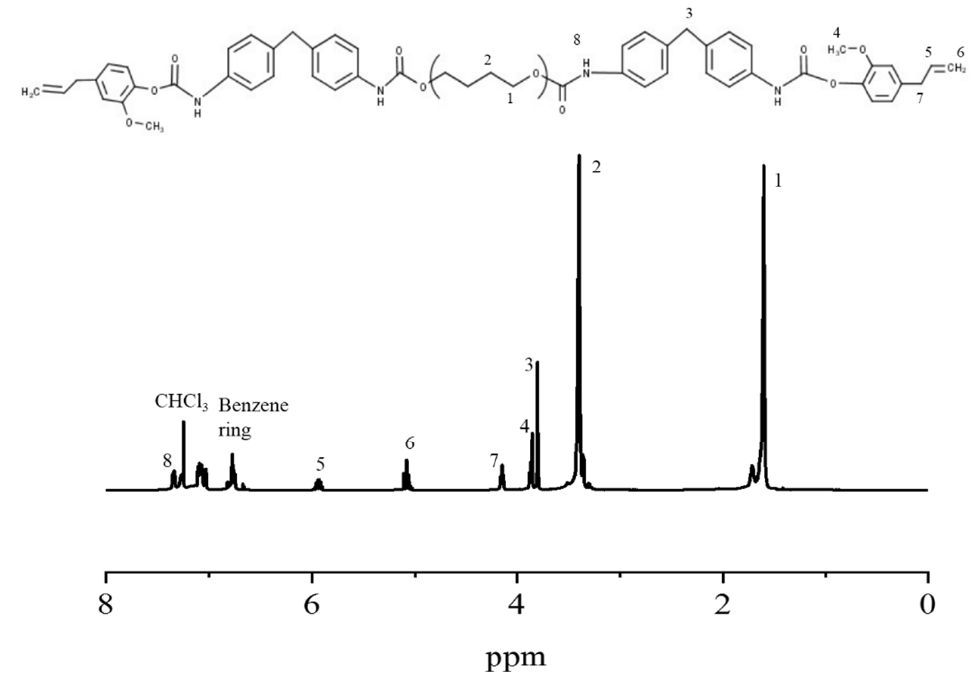
Figure 2. 1 H-NMR spectrum of ETPU.